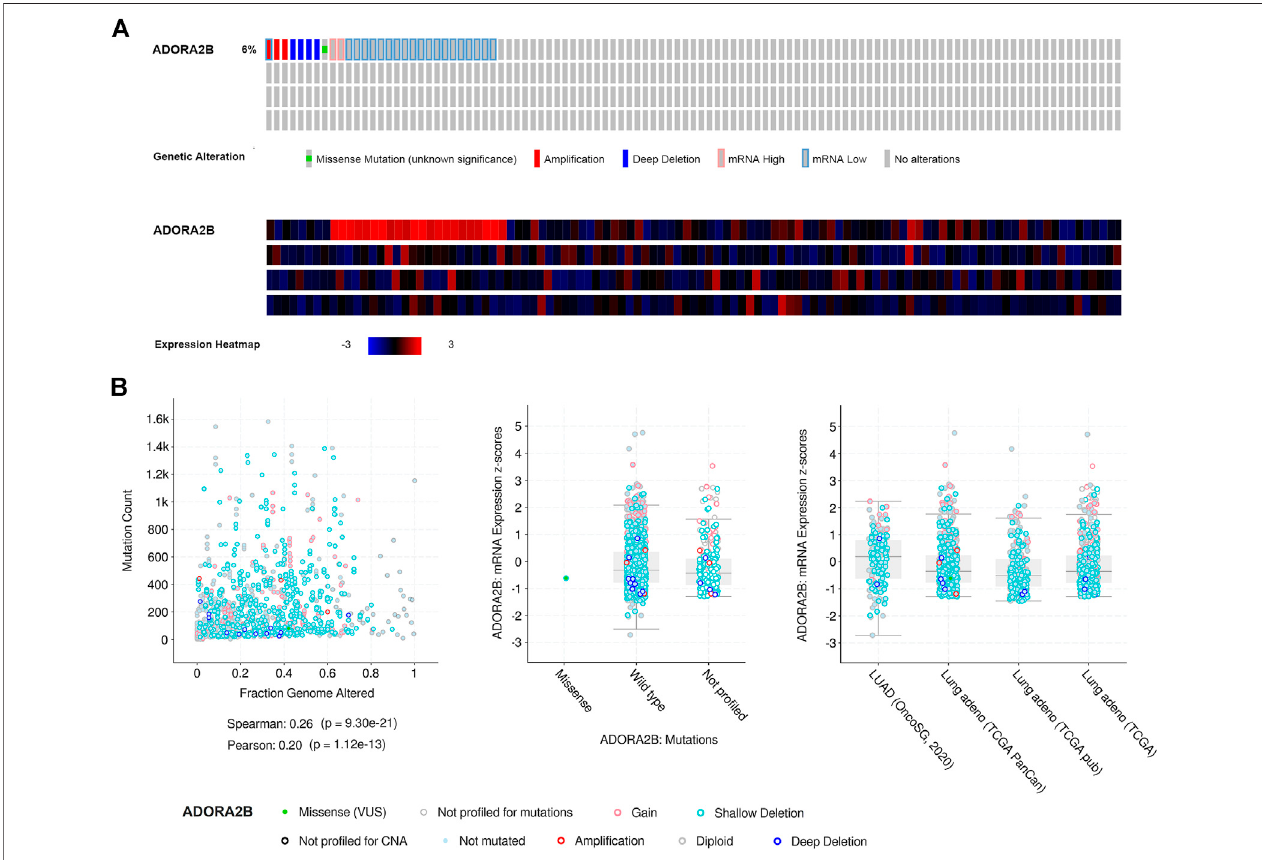
FIGURE 3 | Frequency and type of ADORA2B alterations in LUAD. (A) OncoPrint of ADORA2B alterations in LUAD (cBioPortal) and (B) plots of ADORA2B alterations in LUAD with clinical attributes and mutations